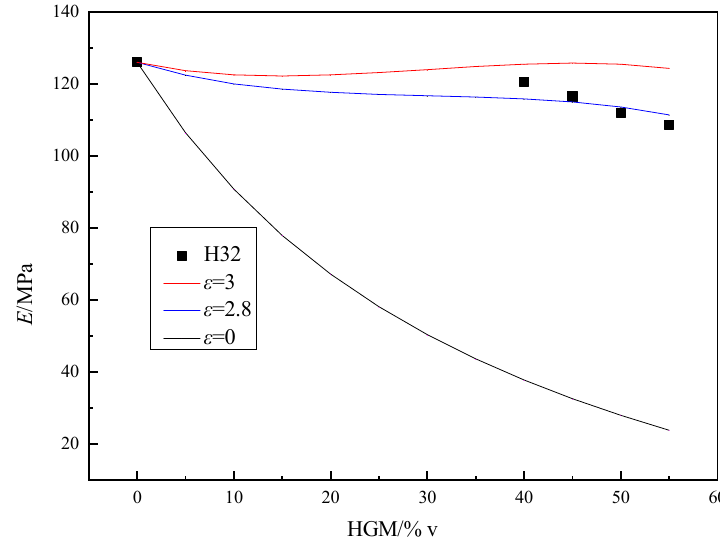
Figure 7. The relationship between the compressive strength and volume fraction of AG-80 epoxy resin-based buoyancy materials.